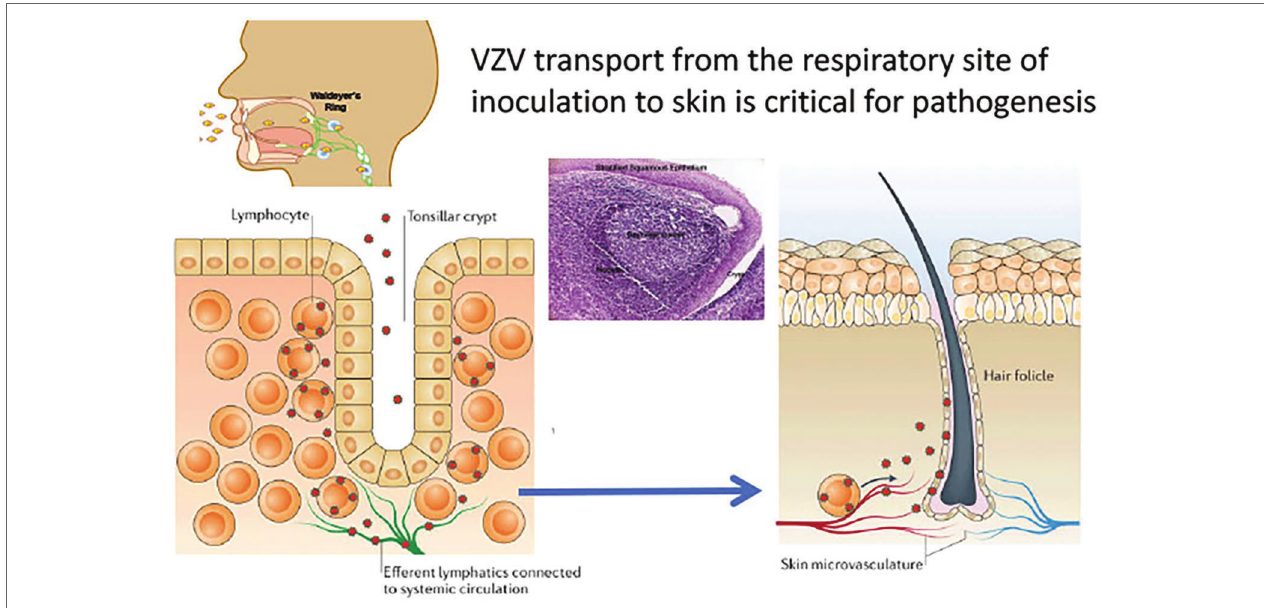
FIGURE 2 | VZV tropism for tonsil T cells. According to the model of VZV cell associated viremia, tonsil T cells are infected following VZV inoculation and replication in respiratory mucosal epithelial cells. T cells traffic into and out of tonsils across the squamous epithelial cells that line the tonsillar crypts (left panel). Single cell high dimensional multiparametric studies showed that VZV infection of the tonsil T cells induces remodeling that alters the T cells to a phenotype that promotes skin trafficking. Adapted from Zerboni et al.